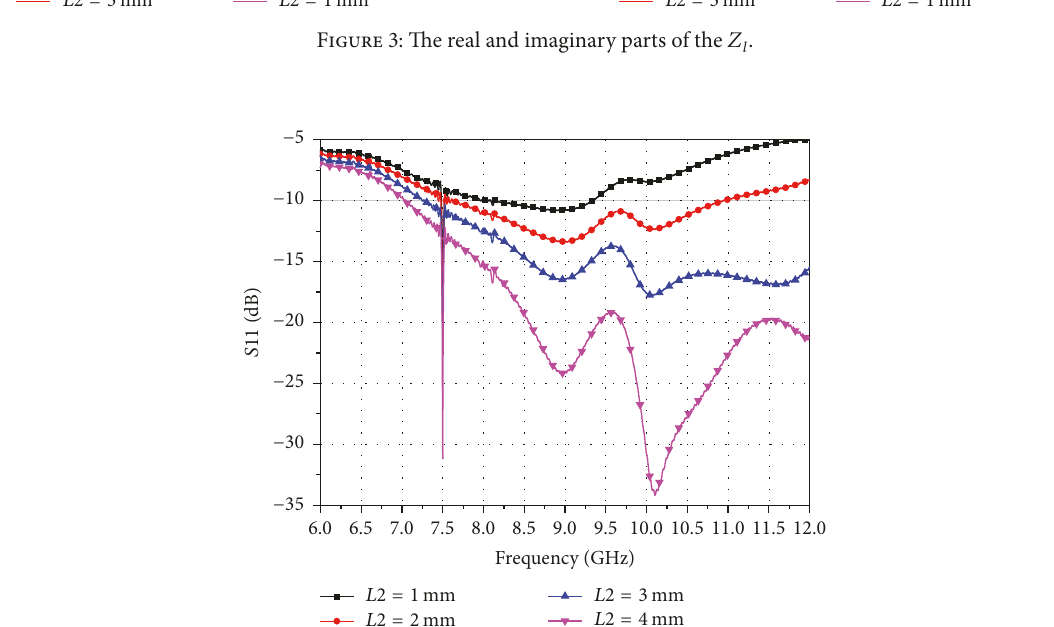
Figure 4: Simulated 𝑆11 for the different feeding point